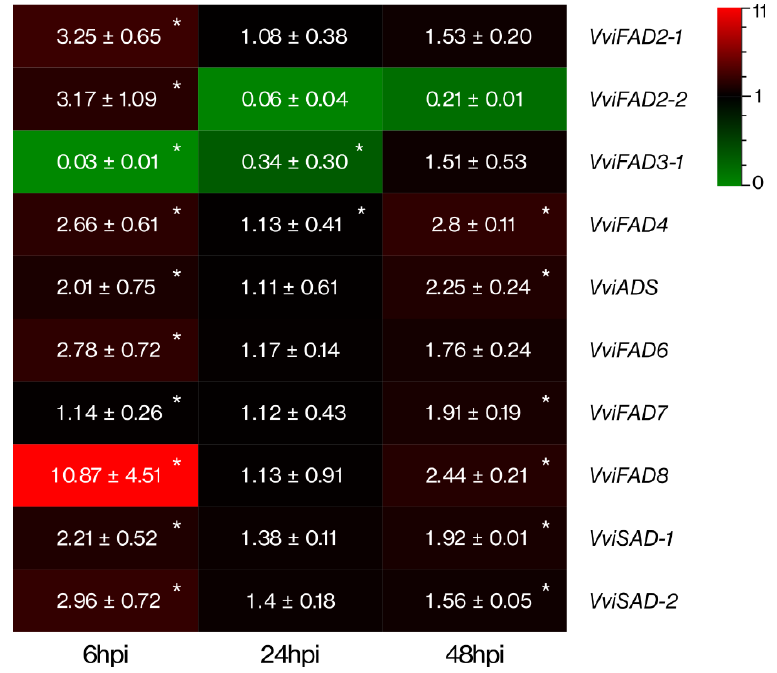
Figure 5. Expression analysis of FA desaturases genes of V. vinifera cv. Regent leaves upon inoculation with P. viticola . The gene transcript’s fold-change relative to controls, at each time point (6, 24 and 48 hpi), are represented for: VviFAD2-1 ; VviFAD2-2 ; VviFAD3-1 ; VviFAD4 ; VviADS ; VviFAD6 ; VviFAD7 ; VviFAD8 ; VviSAD-1 ; VviSAD-2 . Fold-change values are relative to expression in mock-inoculated leaves. Asterisks indicate significant differences ( p < 0.05).